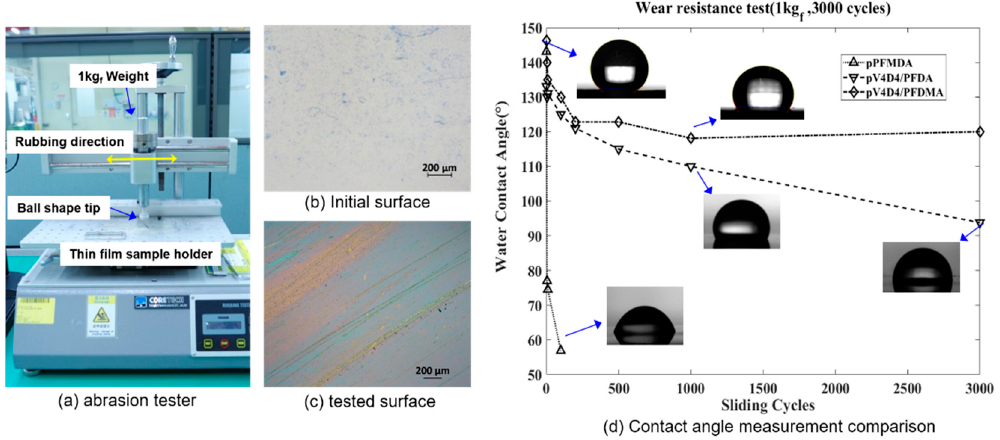
Figure 6. ( a ) Abrasion test set-up; ( b ) microscopic image of the initial surface; ( c ) microscopic image of the tested surface; and ( d ) contact angle